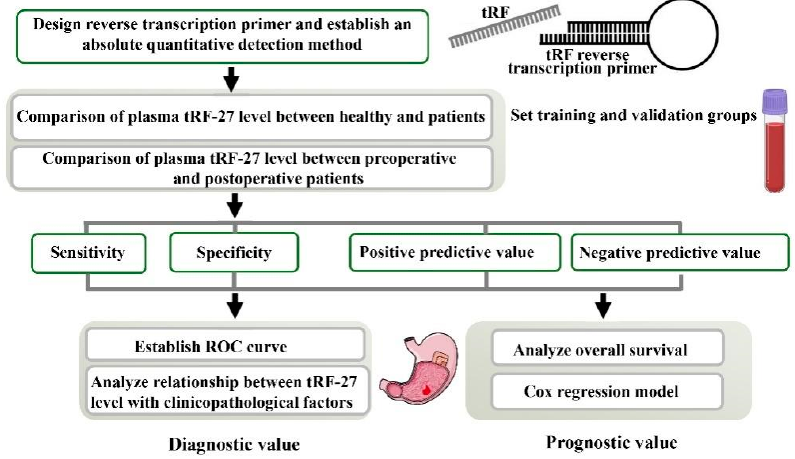
Figure 1. Flow chart of the study design. ROC, receiver operating characteristic.